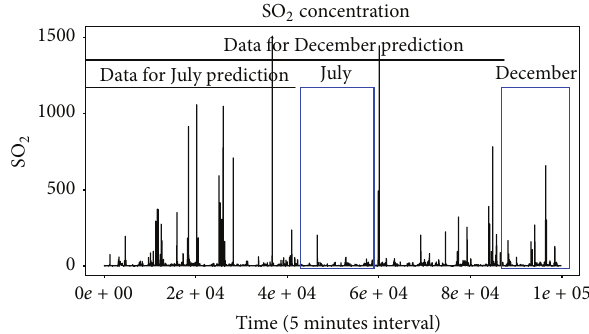
Figure 1: Time series of SO 2 concentrations registered on the control station. Data from July and December were used to validate the